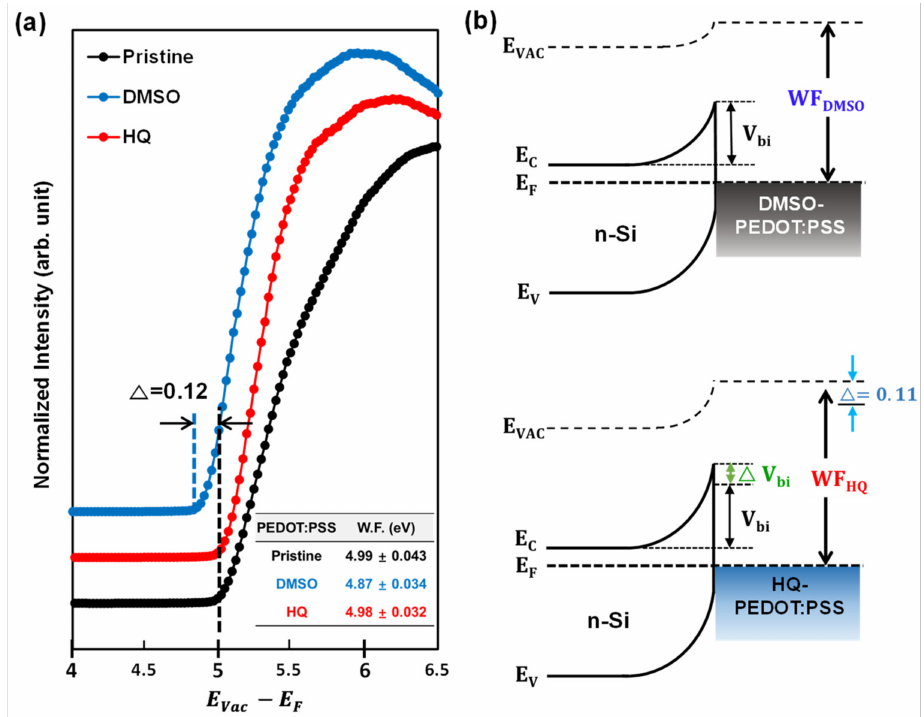
Figure 7. UPS results: ( a ) UPS secondary cut-off region and measured work function (W.F.) values and ( b ) energy diagram of cells based on the n -Si/PEDOT:PSS(DMSO, HQ)